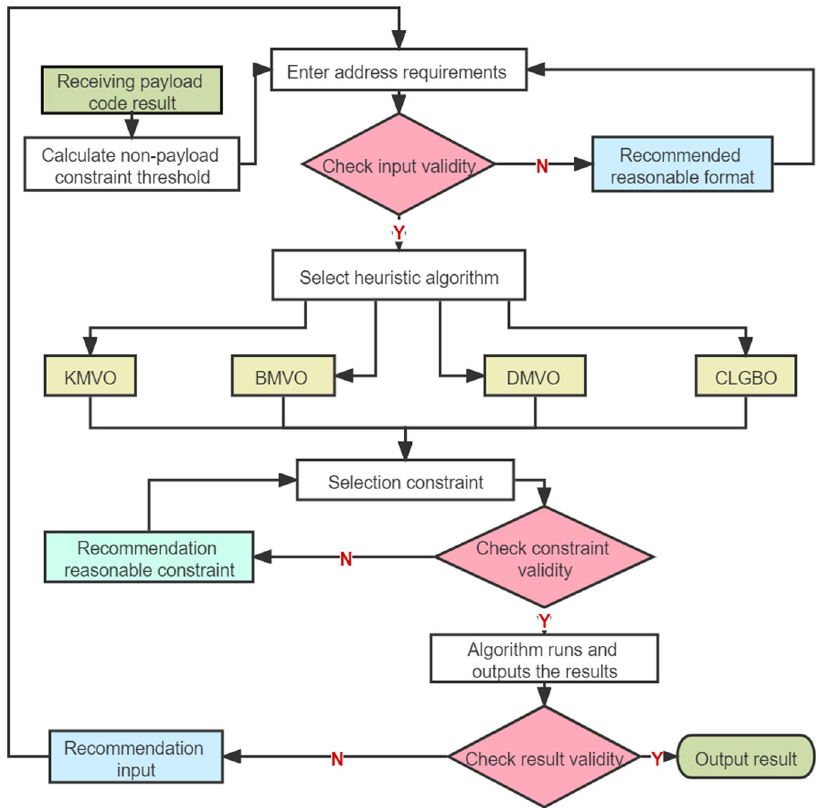
Fig. 8 Constraints and algorithms are optional threshold adaptive non-payload coding in the non-payload combination constraint by the result of payload, as shown in Fig. 8. Moreover, reducing the coordination error rate in DNA data storage by adaptively generating coding thresholds can improve the throughput and reduce the sequencing coverage. Previous work has